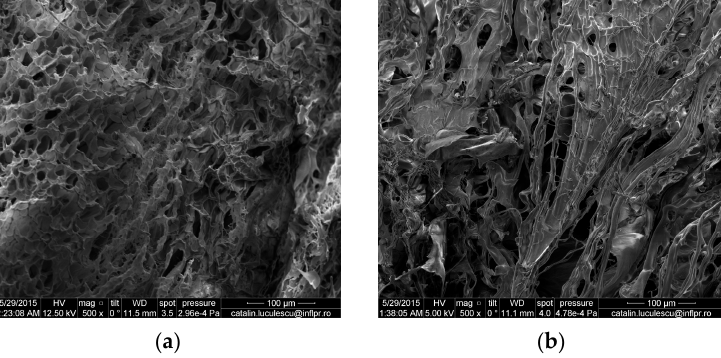
Figure 11. Scanning electron micrographs of hydrogels with 7.40 × 10 − 3 mol/L PP and 5.90 × 10 − 3